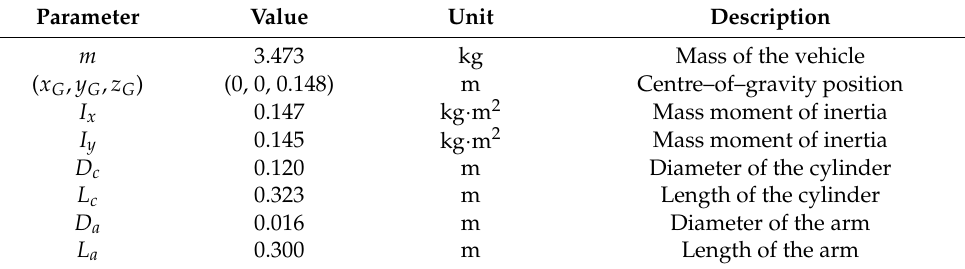
Figure 2. Diagram of the overall structure of Nezha. Table 1. The physical parameters of Nezha.